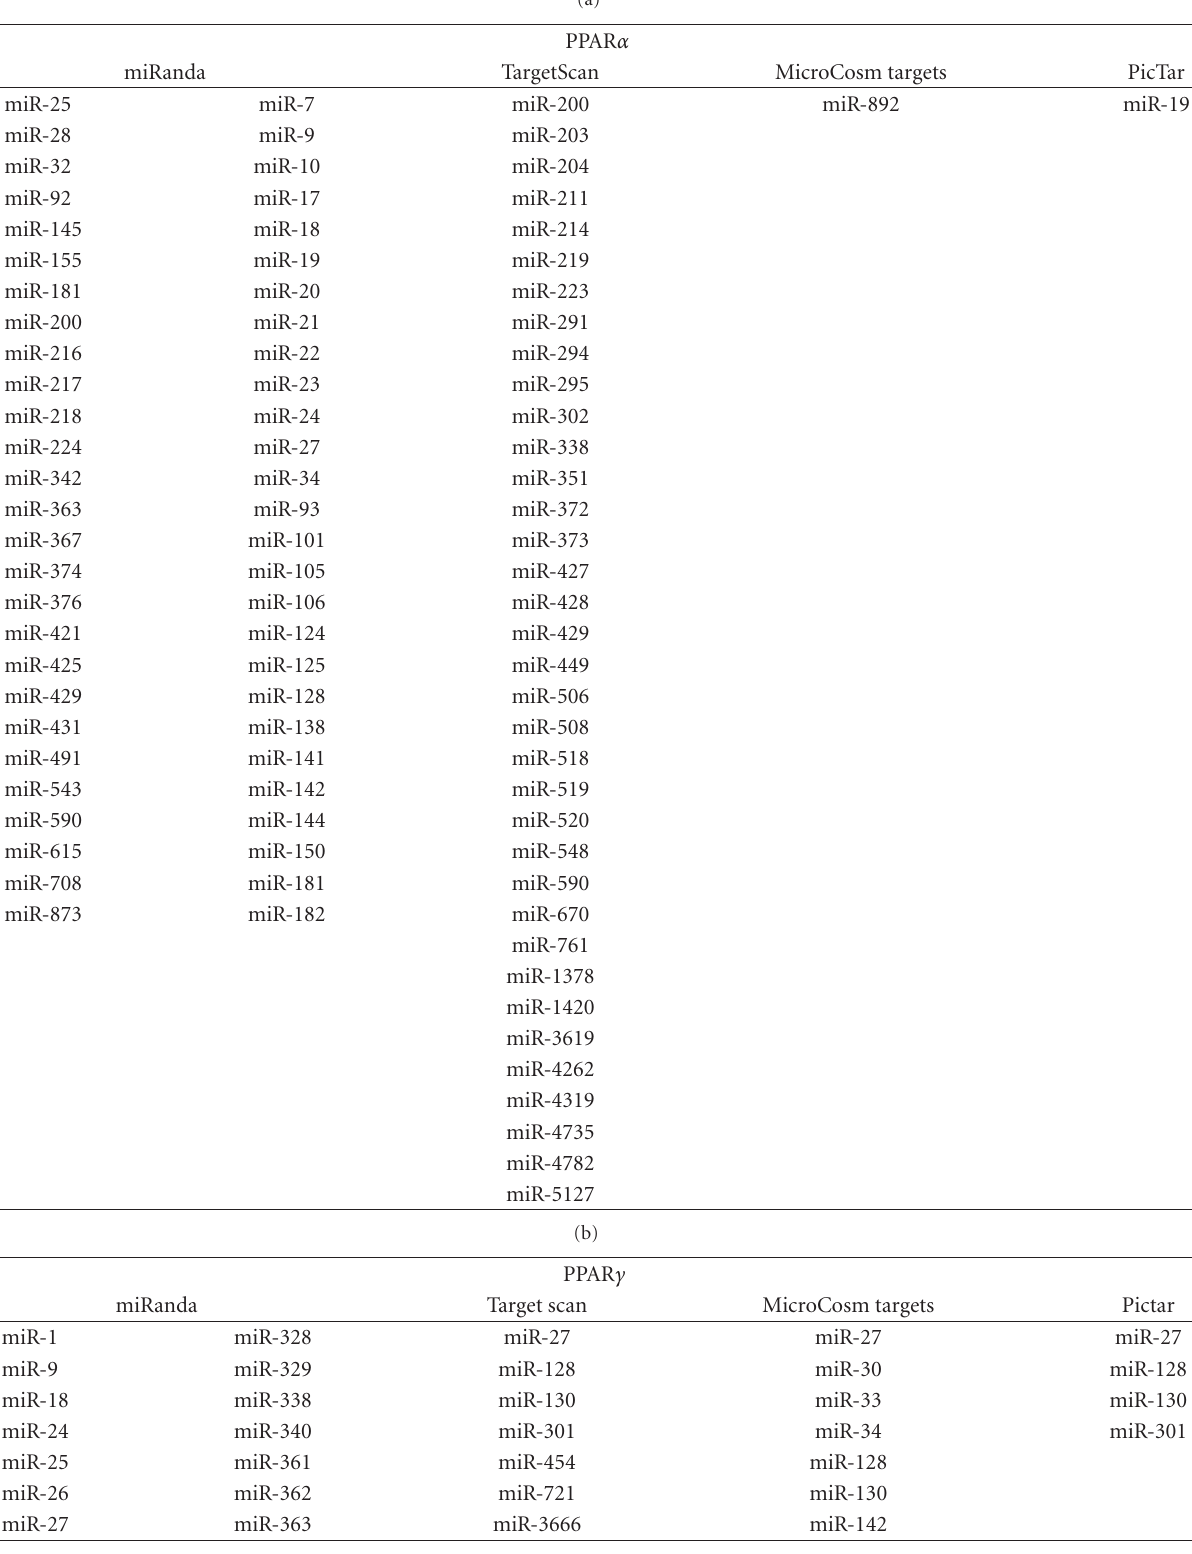
Table 1: miRNAs potentially targeting PPAR γ , PPAR α and PPAR β / δ . Four di ff erent databases, that is, miRanda (http://www.microRNA .org/), PicTar (http://www.pictar.org/), TargetScanHuman (http://www.targetscan.org/) and MicroCosm Targets